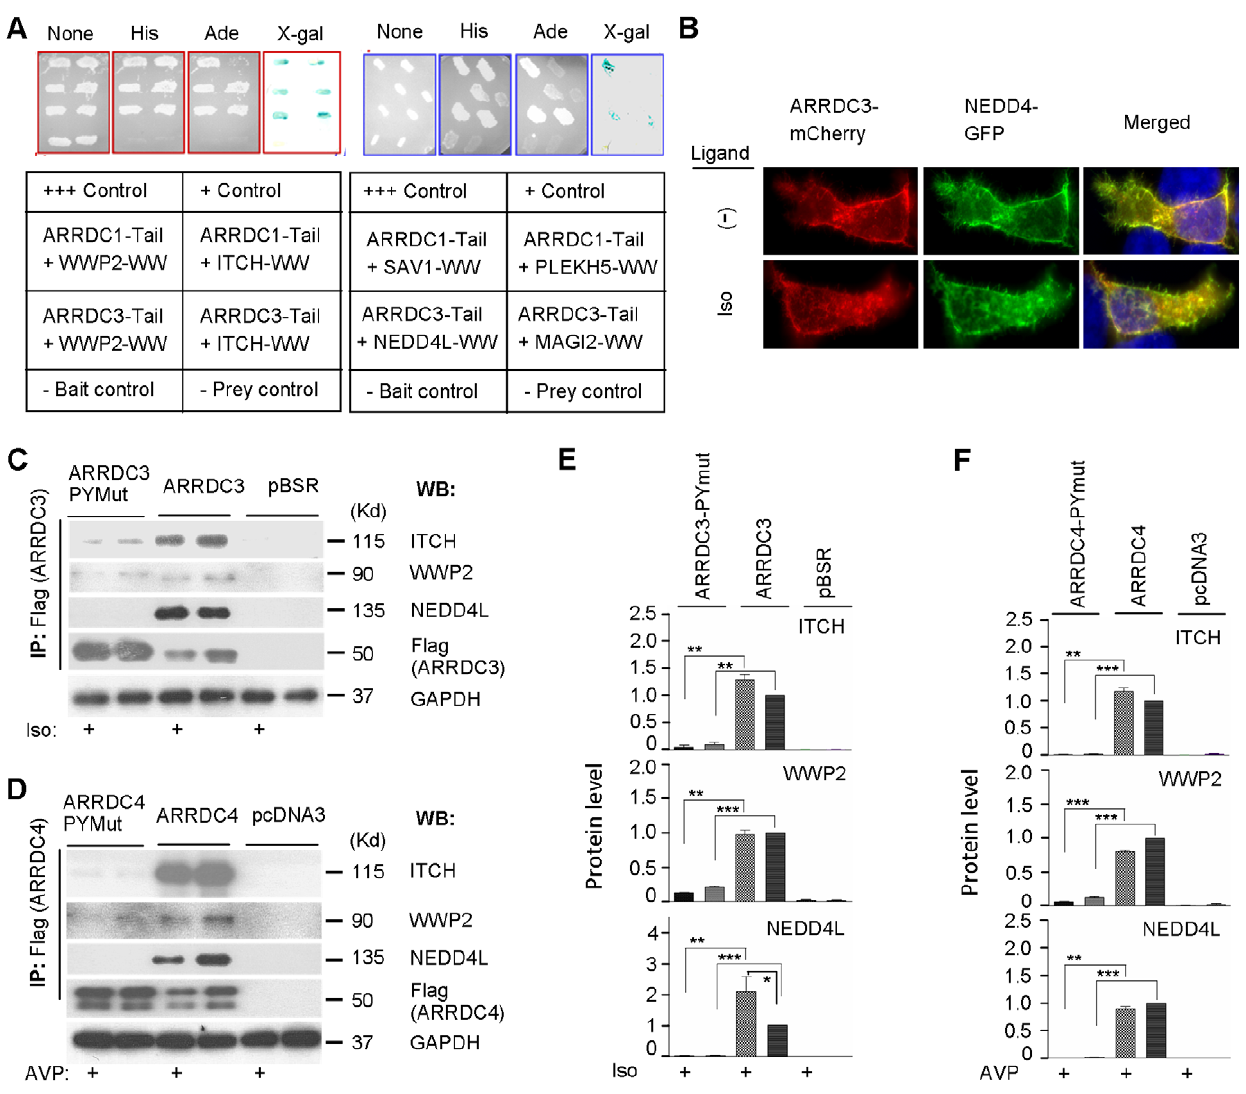
Figure 4. Recruitment and activation of Nedd4 E3 ligases by alpha arrestins. ( A ) Interactions of PY motif-containing alpha arrestin tails and WW region fragments demonstrated by yeast two-hybrid analysis. Bait plasmid (pDEST32-ARRDC1 or -ARRDC3) which contain two sets of PY motifs and prey plasmid (pDEST22-ITCH, -WWP2, -SAV1, -PLEKHA5, -Nedd4L, or -MAGI-2) which contain 1–4 sets of WW domains were transformed into competent yeast strain MaV203. pEXP32/Krev1 plus pEXP22/RalGDS-wt was included as strong positive control, pEXP32/Krev1 plus pEXP22/RALGDS- m1 weak positive control, pEXP32/Krev1 plus pEXP22/RALGDS-m2 and empty bait vector pDEST32 plus empty prey vector pDEST22 negative controls. Positive clones growing on SD/-Trp/-Leu/-His/-Ura plates are selected and the activity of lacZ reporter gene is examined with colony-lift filter assay by X-gal. ( B ) Subcellular colocalization of alpha-arrestin-mCherry and Nedd4 in HA-b2AR permanent cell lines. HA-b2AR permanent cells were transiently co-transfected with ARRDC3 -mCherry and pBJ-Nedd4-myc constructs. After 24 h, transfected cells were serum-starved, treated with 1 uM Iso for 30 m, and fixed. Nedd4 was stained with mouse monoclonal anti-myc antibody followed by incubation with Alexa Fluor 488-conjugated goat anti-mouse second antibody. Confocal epifluorescence images were obtained (aArr, red ; Nedd4, green ). ( C ) Co-immunoprecipitation of alpha arestin ARRDC3 and Nedd4 family E3 ubiquitin ligases with overexpressed b2AR. Empty vector, pBSR-ARRDC3-Flag, or pBSR-ARRDC3-Flag PY motif mutant construct was cotransfected respectively with pcDNA3-HA-b2AR-V5. After 24 h incubation, cells were serum-starved and treated or not with 1 uM Iso for 5 m. The transfected cells were lysed, lysates were immunoprecipitated (IP), and analyzed by western blot (WB). ( D ) Co-immunoprecipitation of aArr ARRDC4 and Nedd4 family E3 ubiquitin ligases with overexpressed V2R, unstimulated or 5 m post 1 uM AVP stimulation. ( E, F ) Histograms of C and D from three different experiments; p-values were calculated by comparing levels of ligand-treated or non-treated samples with their respective vector control (p value levels and thin/bold lines used as in Fig.